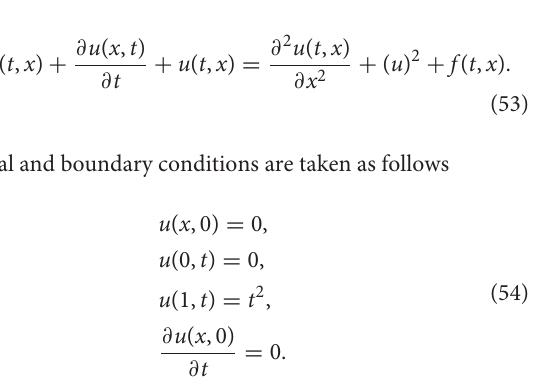
FIGURE 6 | 3D-plot of absolute error for m = 10.